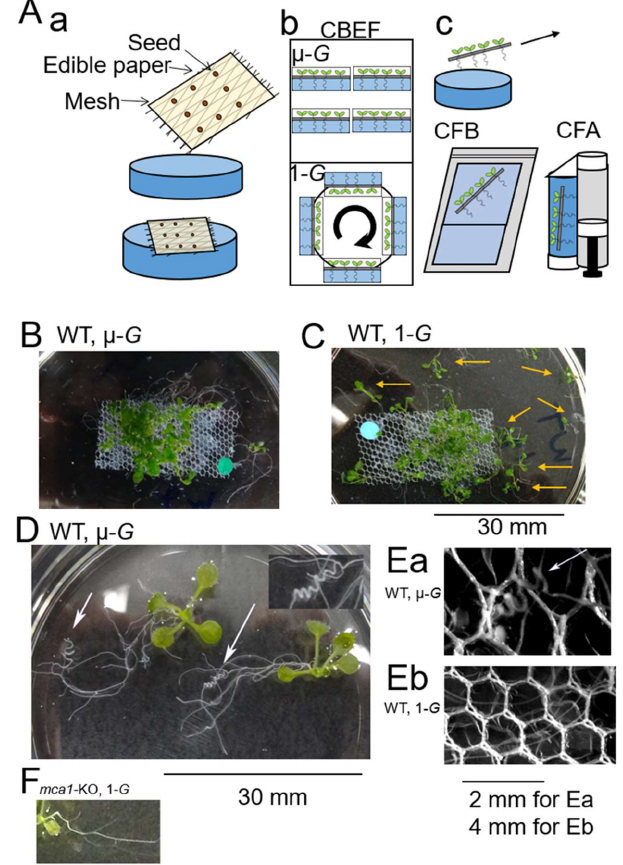
Figure 1. Seedlings entangled with a mesh under different conditions. ( A ) Schematic illustration of experiments. ( a ) Seeds were attached to an edible paper (oblate) adhered to a nylon mesh on the earth, and the ‘seed paper’ was attached to the surface of the gel plate in a petri dish on the ISS; an oblate polymer made with starch was dissolved on the gel plate, the cultivation was initiated, and seedlings were grown on the gel plate. ( b ) Arabidopsis seedlings were grown on the gel plate under micro- G (upper chambers of CBEF) and centrifugation-generated 1- G conditions from the stem to the root direction (lower chamber of CBEF; cell biology experiment facility) as in the case of the gravitational force on the earth’s surface, equipped with PEU (plant experiment unit, a small growth chamber for plants). ( c ) Seedlings were collected by peeling off the nylon mesh from the gel plate and inserted to an apparatus for RNA-stabilization (CFB unit) and for paraformaldehyde (CFA unit), and seedlings were returned to the earth and examined. Plants were submerged in the fixative (blue) inside the plastic bag (CFB; chemical fixation bag) or inside the cylinder (CFA; chemical fixation apparatus). The fixative was introduced by sliding a piston in CFA. ( B ) Seedlings grown under micro- G conditions on the ISS. ( C ) Seedlings under 1- G conditions generated by centrifugation on the ISS. Arrows indicate the dispersed seedlings. ( D ) Two typical seedlings under micro- G conditions without mesh. Arrows indicate the root coils. The region shown by the right arrow is magnified (2.5 times) (upper inset). Two seedlings dispersed from the mesh are imaged to show the coiled roots. The insert in panel ( D ) shows the magnified root coil. ( E ) Roots along with the mesh. ( Ea ) A root coil (shown by the arrow) found in a space micro- G plant; ( Eb ) straight and curved roots were found in space 1- G seedlings. ( F ) An image of mca1 -KO seedlings with roots that do not coil under 1- G on ISS. Images of wild-type seedlings are shown in panels ( B – E ) and mca1 -KO seedlings in ( F ). Images in ( D , F ) share the same scale